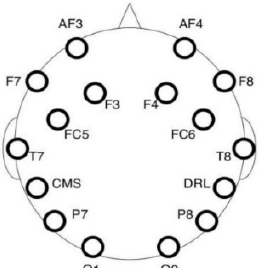
Figure 4. Emotiv electrode placement. The Emotiv Epoc headset is composed of 14 electrodes and 2 electrodes references (Source of image: Emotiv and Emotiv EPOC neuroheadset).